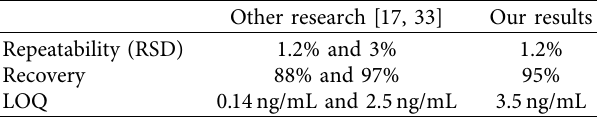
Figure 5: Chromatogram of blank sample (black) and blood serum spiked with mix compound and treated with MIP-MMA (blue). Table 3: Comparison of repeatability, recovery, and LOQ values with other research